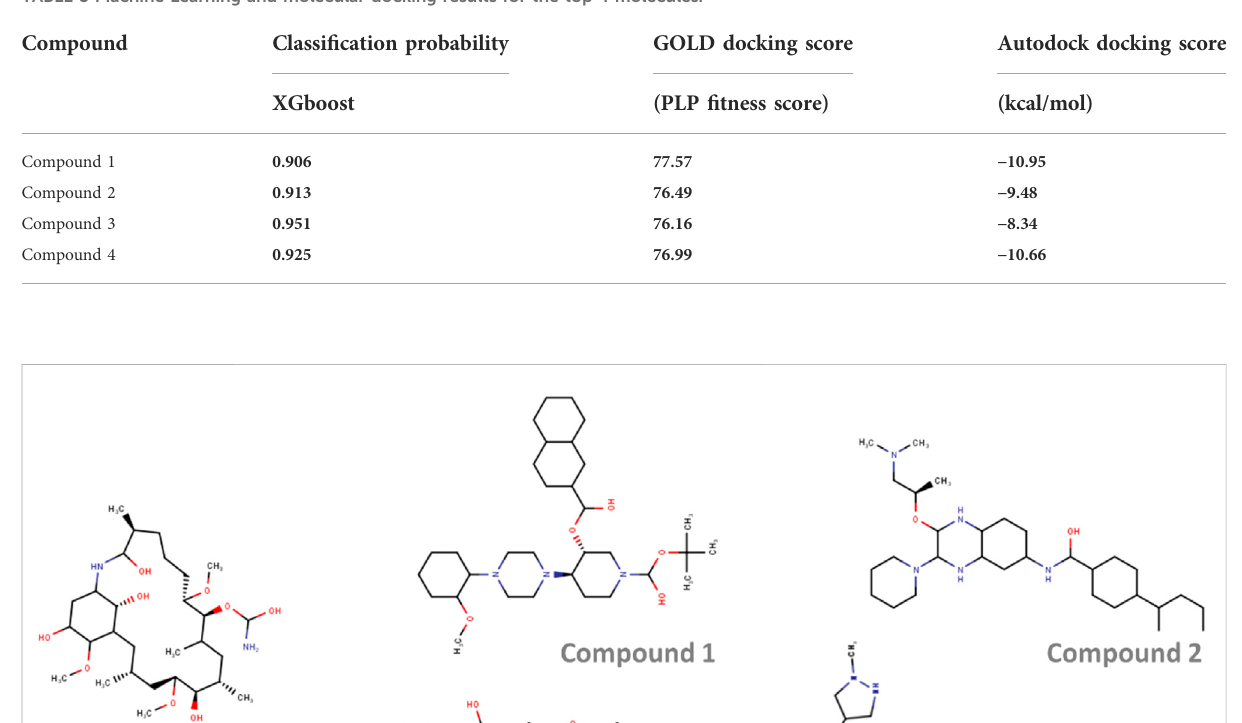
TABLE 5 Machine Learning and molecular docking results for the top 4 molecules.